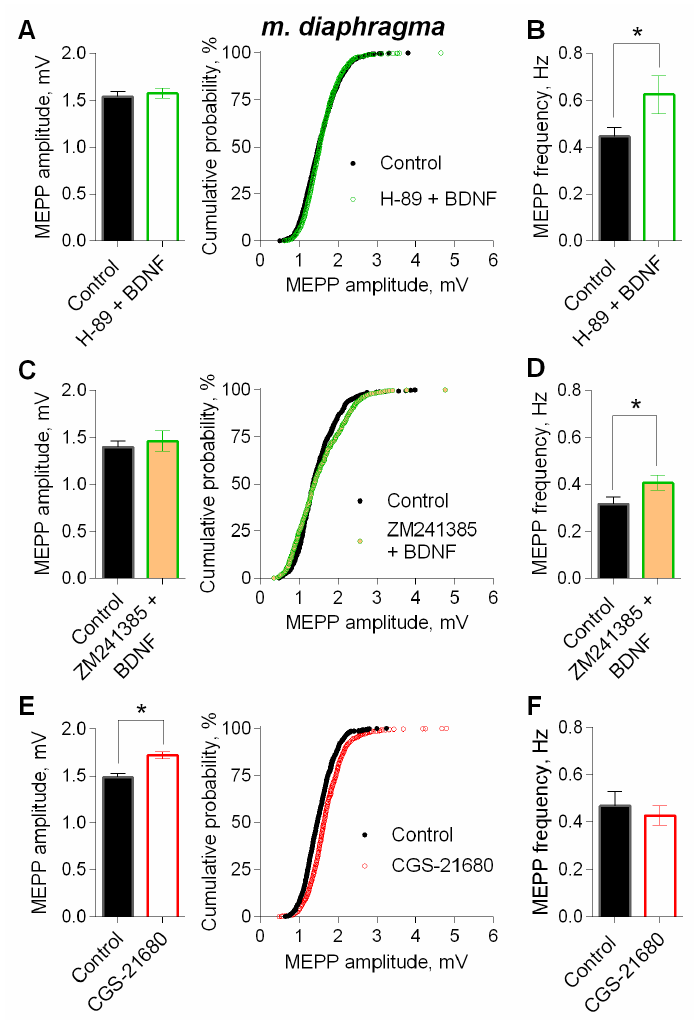
Figure 11. Intracellular signaling mechanisms underlying BDNF-induced upregulation of spontaneous neuromuscular transmission at the mouse diaphragm NMJs. The potentiating e ff ect of BDNF (1 nM) on the amplitude of MEPPs depends on PKA and the activity of adenosine A 2A receptors. ( A ) Mean amplitude of MEPPs (left) and cumulative probability plots (right) in control ( n = 28) and after BDNF was added in the presence of PKA inhibitor H-89 (1 µ M) ( n = 29). ( B ) Mean frequency of MEPPs in control and upon application of BDNF in the presence of H-89. ( C ) Mean amplitude of MEPPs (left) and cumulative probability plots (right) in control ( n = 19) and after BDNF was added in the presence of A 2A receptor antagonist ZM241385 (10 nM) ( n = 22). ( D ) Mean frequency of MEPPs in control and upon application of BDNF in the presence of ZM241385. ( E ) Mean amplitude of MEPPs (left) and cumulative probability plots (right) in control ( n = 21) and upon application of A 2A receptor agonist CGS21680 (100 nM) ( n = 29). ( F ) Mean frequency of MEPPs in control and in the presence of CGS21680. Histograms and error bars represent the mean ± SEM. * p < 0.05 compared to control. In order to evaluate the possible additive or occlusive crosstalk between the neurotrophin and A 2A -mediated e ff ects on spontaneous ACh release, we applied BDNF 30 min after the addition